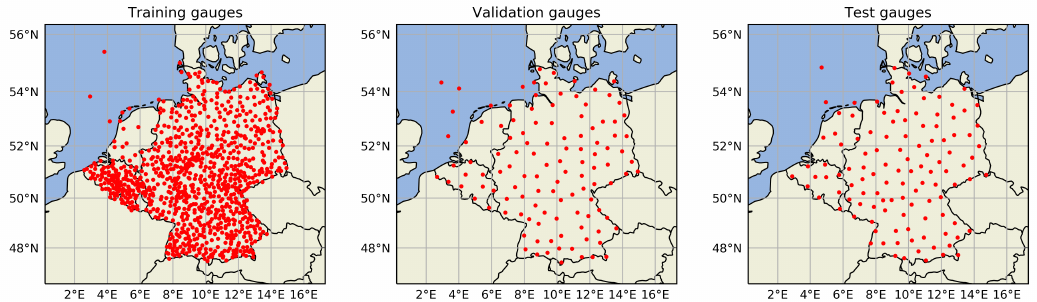
Figure 4. Location for the training, validation and test automatic rain gauges.